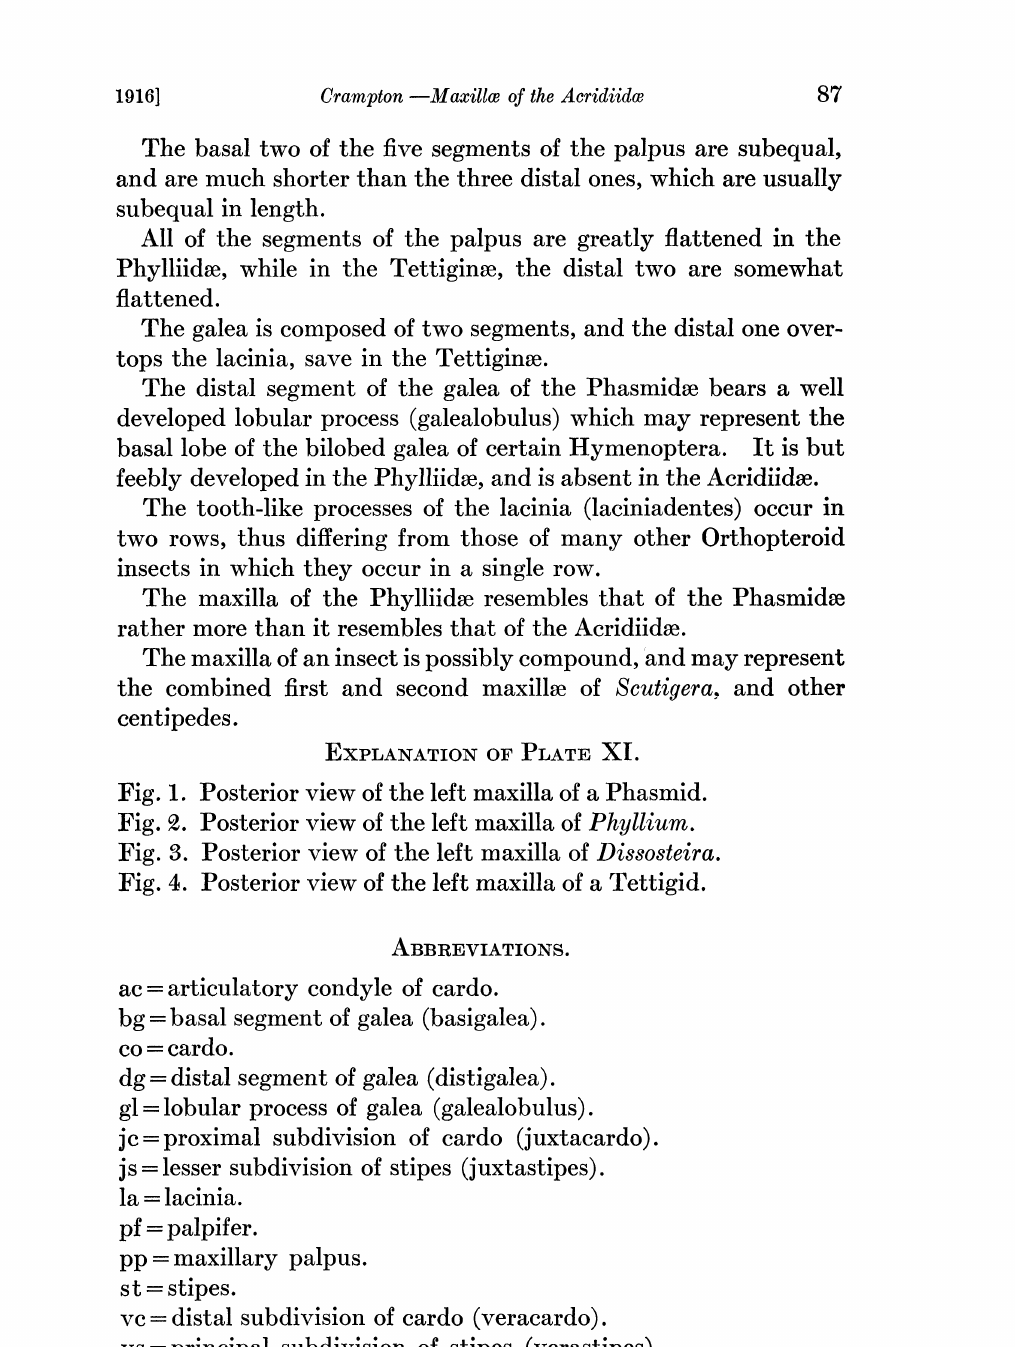
. Fig. 1. Posterior view of the left maxilla of a Phasmid. Fig. Posterior view of the left maxilla of Phyllium. Fig. 3. Posterior view of the left maxilla of Dissosteira. Fig. 4. Posterior view of the left maxilla of a Tettigid. fl-_BBREVIATIONS. ac= articulatory condyle of